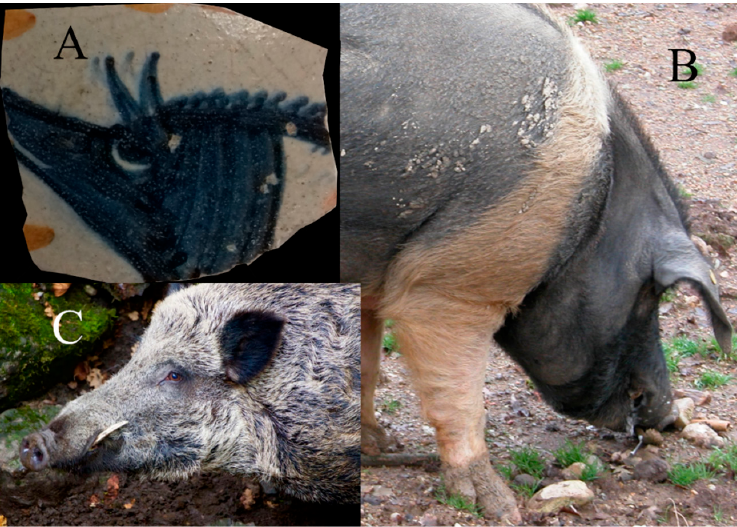
Figure 1. Representation of pig vs. extant Cinta senese breed and wild boar. ( A ) Medieval ceramic fragment retrieved from pit 2 at the Graffignano Castle. The represented pig has a white belt and long snout. ( B ) Cinta senese picture. The typical white belt is evident. ( C ) Wild boar picture. The snout is longer than in S. scrofa